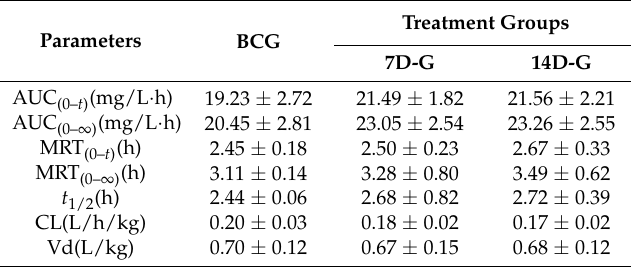
Table 5. Effects of SGI on pharmacokinetic parameter of chlorzoxazone (4.0 mg/kg).